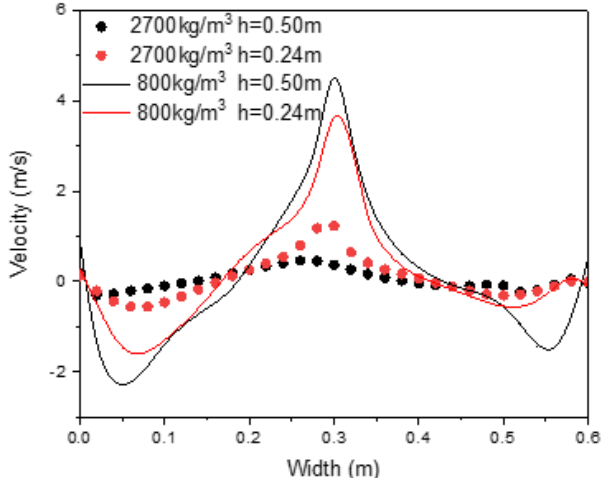
Figure 10. Comparisons of averaged axial velocities of particles with density of ρ p = 2700 kg/m 3 and ρ p = 800 kg/m 3 at the height of 0.24 m and 0.5 m.